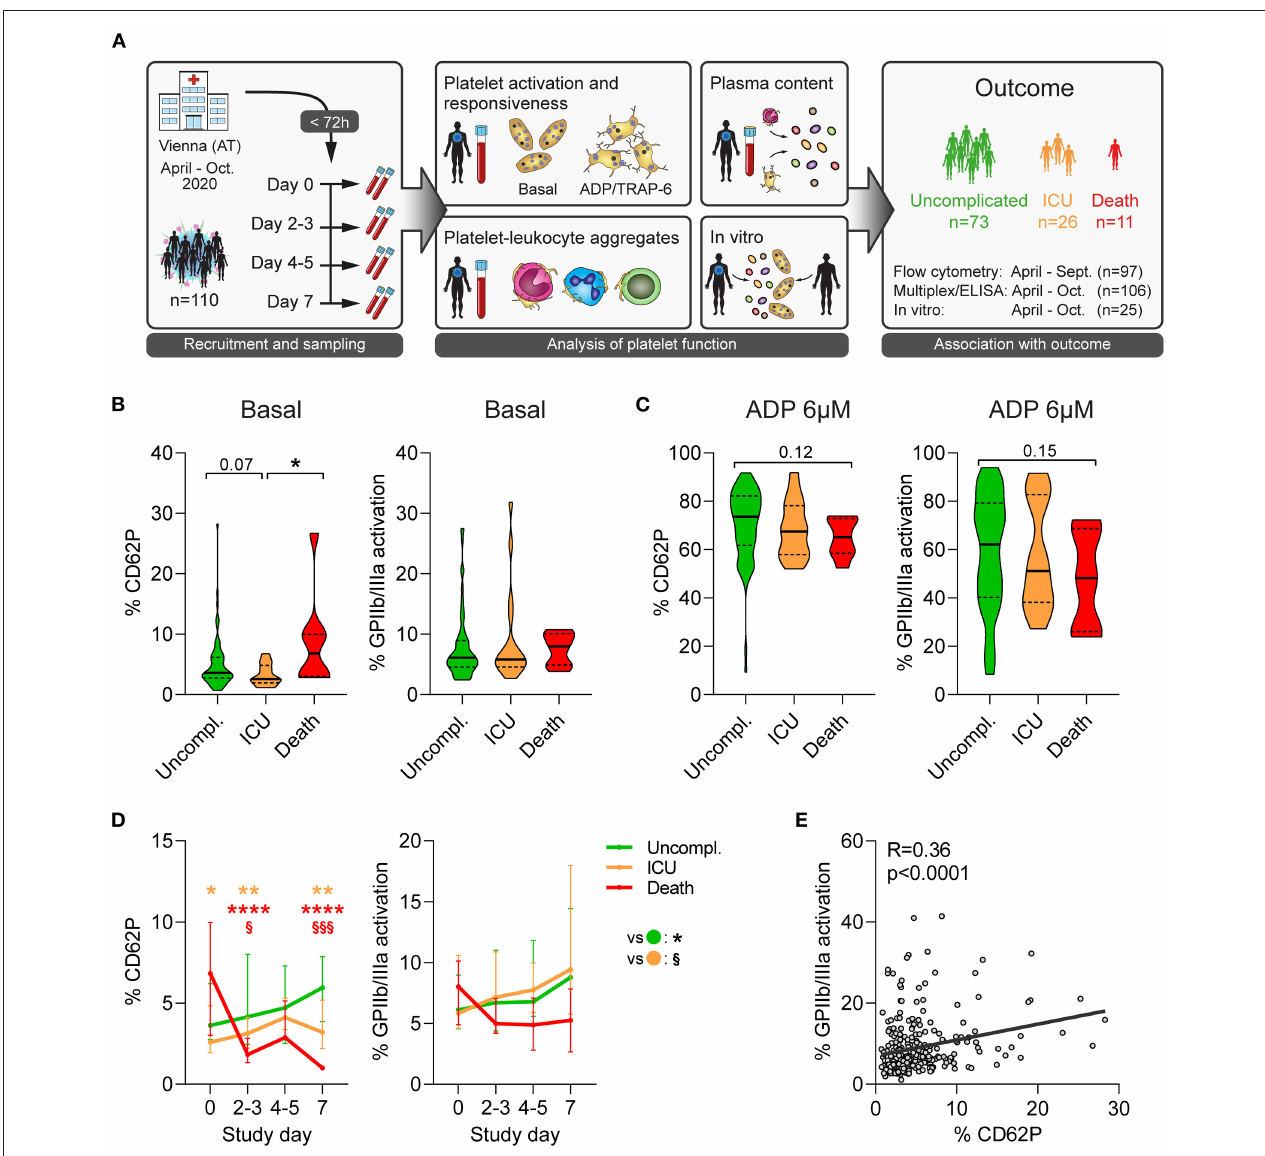
FIGURE 1 | Unfavorable outcome in COVID-19 is associated with declining platelet activity. (A) Study design: 110 patients admitted to the primary COVID-19 hospital in Vienna, Austria, were included in this longitudinal study within 72h after hospital admission and prospectively analyzed. Blood was collected every 2-3 days over 1 week to determine platelet function and elucidate outcome-specific differences. (B,C) Platelet activation upon study entry at (B) basal condition and (C) after stimulation with 6 µ M ADP (15min) was assessed in 97 patients upon hospital admission by quantifying surface CD62P expression and GPIIb/IIIa activation (PAC1 antibody binding). (D) Basal platelet activation was monitored over the span of 1 week after study. Asterisks (*) indicate significant differences to uncomplicated (orange: ICU; red: death), section signs ( § ) indicated significant differences between ICU and death. (E) Correlation of basal CD62P expression and GPIIb/IIIa activation of platelets. n = 97 patients. * p < 0.05, ** p < 0.01, **** p < 0.0001; § p < 0.05, §§§ p <